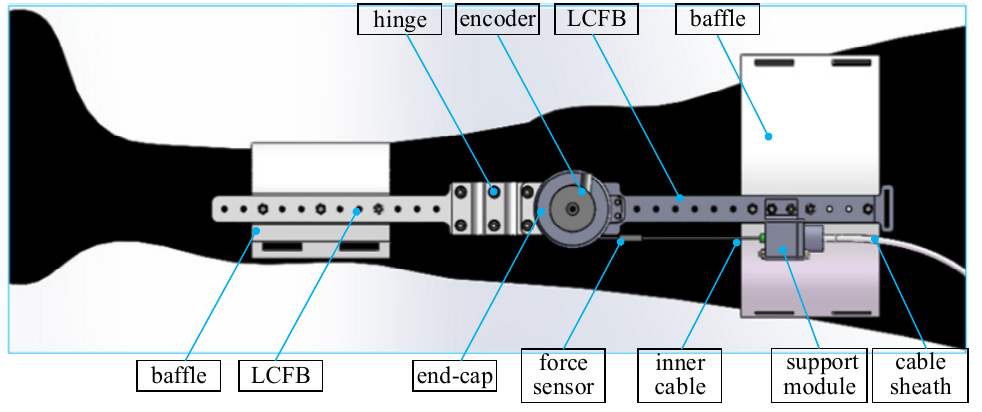
Figure 1. The fixation mechanism of the knee joint [31].